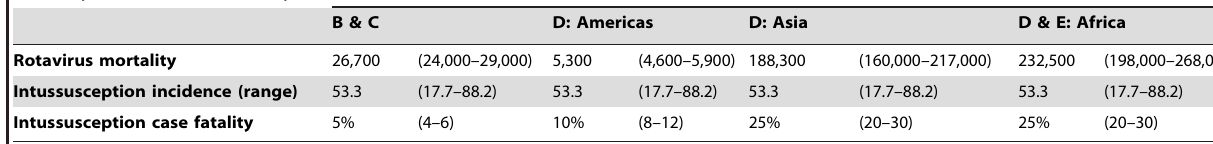
Mortality, Incidence, and Fatality